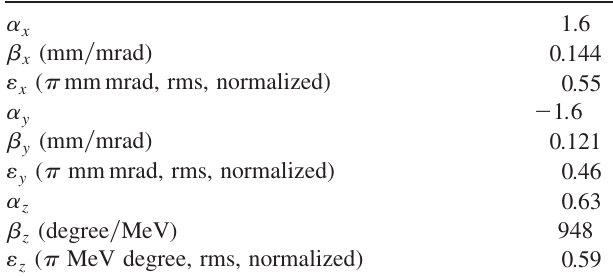
TABLE VII. Output beam parameters from a single beam RFQ linac obtained from the PARMTEQM simulation.